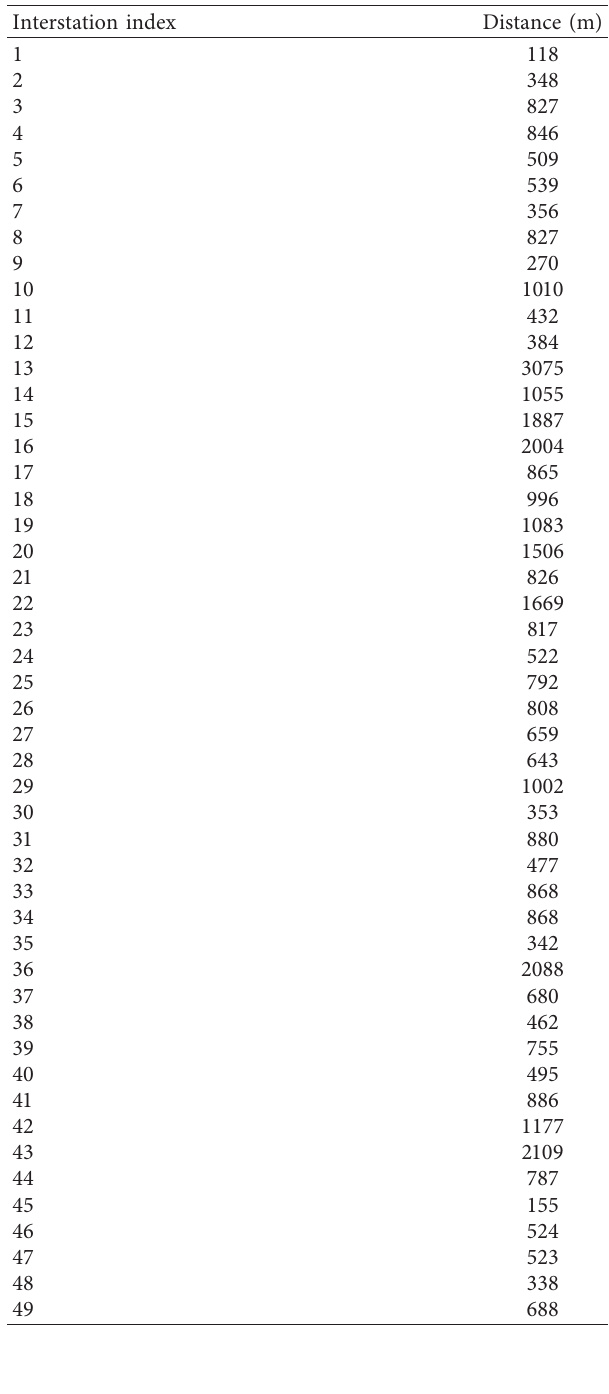
Table 3: Distance of station interval.